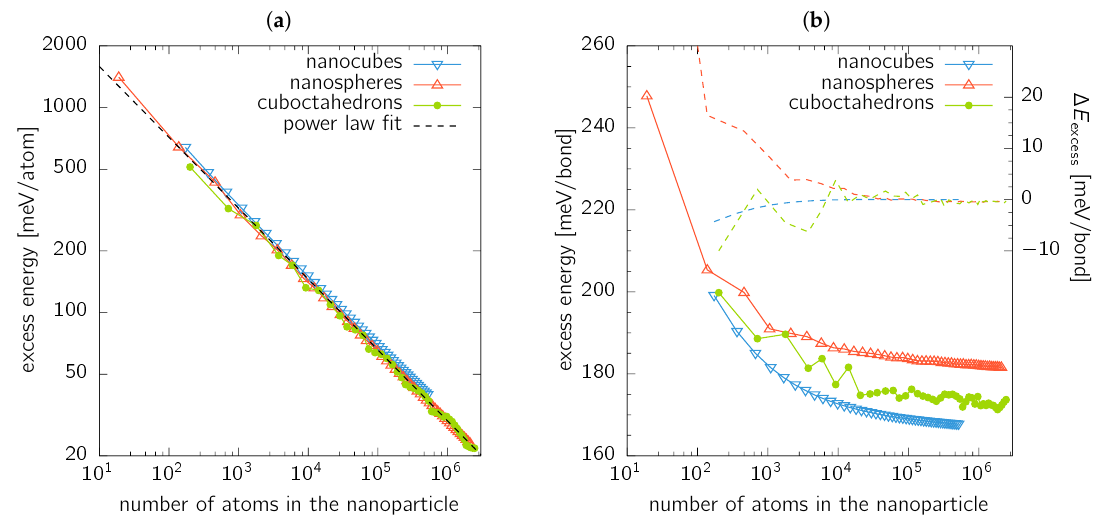
Figure 6. Excess energy, E excess , of nanoparticles with respect to the bulk fcc Au as a function of the number, N , of atoms forming the nanoobject. E excess is normalised to ( a ) number of the atoms forming the nanoparticle, and ( b ) to the number of broken bonds. The dashed lines in (b) show the difference between the actual value of E excess as calculated by MM, and a fitted value using Equation